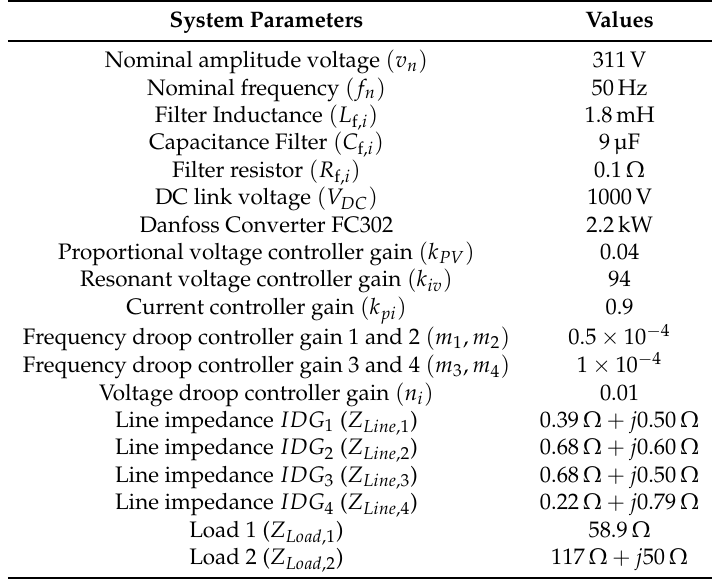
Table 1. Microgrid Setup Parameters.